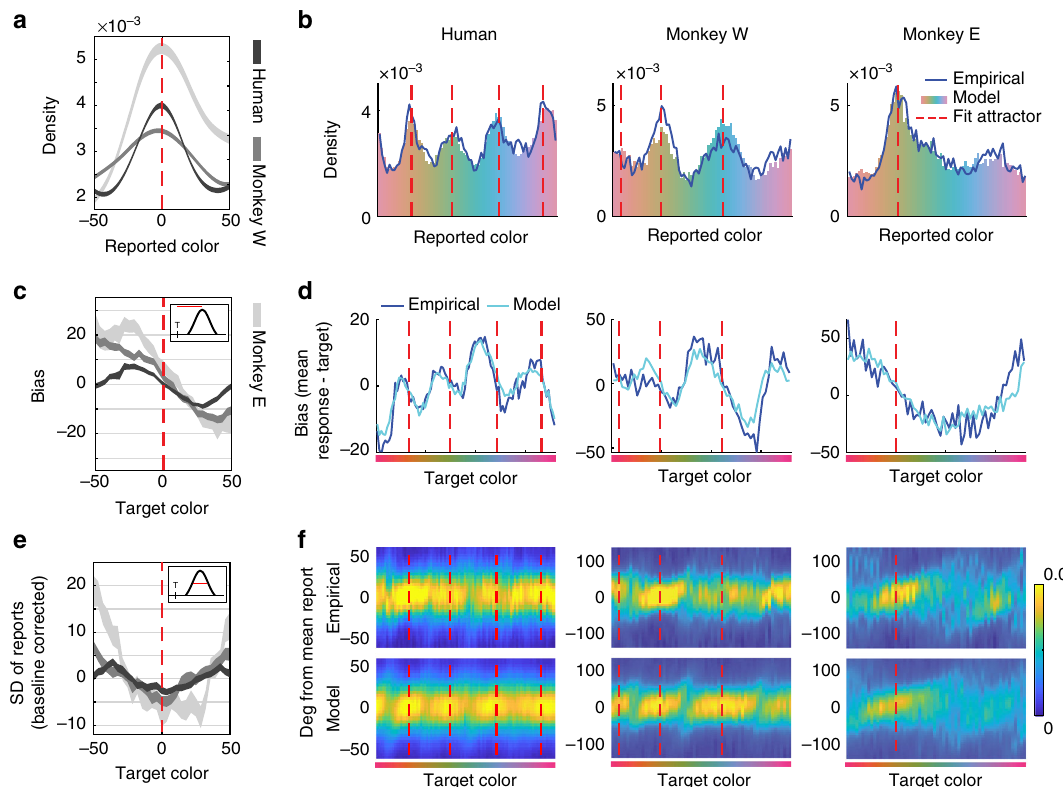
Fig. 4 Attractors explain the distribution, bias, and precision of working memory reports. a Observed distribution of memory reports around fi t attractors (red dashed line). X -axis: degrees in color space. b Distribution of simulated memory reports from the full model fi t to human and monkey subjects. Blue line shows empirical distribution of reports. c Observed bias + / − SEM around fi t attractors. Inset: bias is calculated as the angular distance between the target and mean report. Positive values indicate clockwise (CW) drift; negative values indicate counter-clockwise (CCW) drift. d Mean bias in reports as a function of target color (dark blue line), with predictions from best- fi t models (light blue line). e Observed SD of reports + / − SEM around fi t attractors. f Distribution of memory reports around their mean as a function of target color (top row), with predictions from best- fi t models (bottom row). More precise memory reports are indicated by tighter distributions around their mean. Source data are provided as a Source Data fi